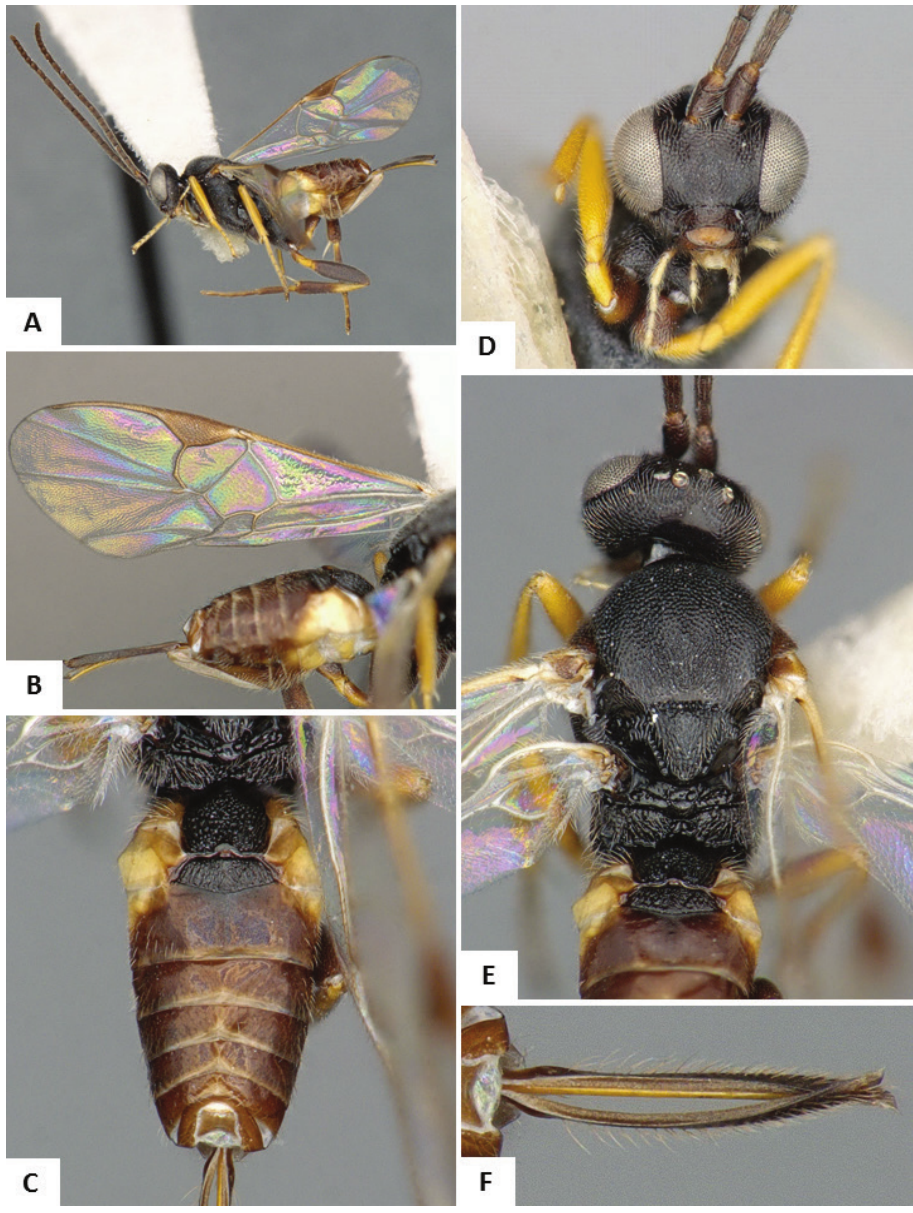
Figure 8. Apanteles hemara female specimen from Oman (Voucher code: